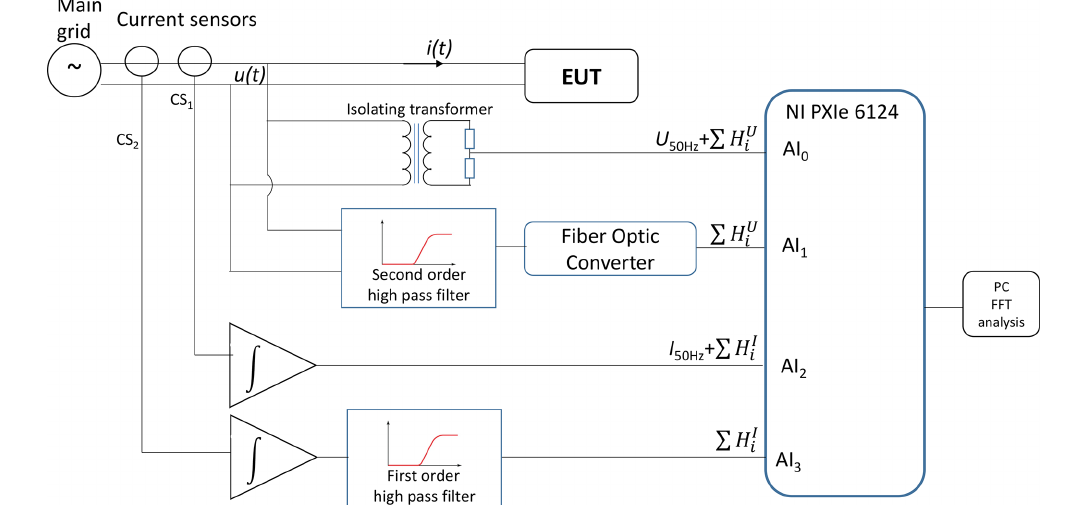
Figure 1. Measurement system for supraharmonic